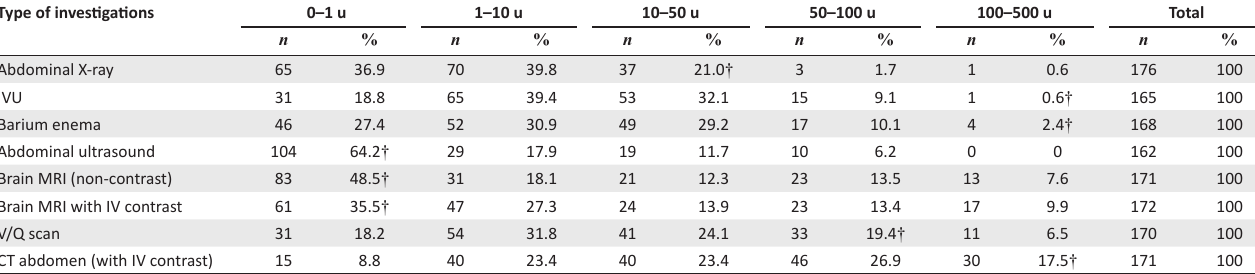
TABLE 3: The numbers of doctors who knew the doses of common but more complex imaging procedures. Type of investigations